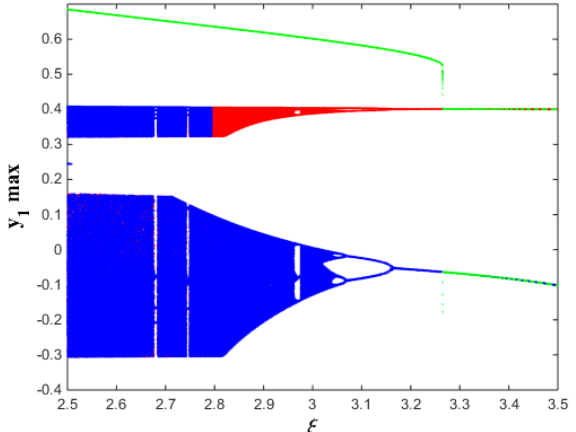
Figure 5. The bifurcation diagram of the integer − order MAVPD system with γ = 0.1, δ = 100, ρ = 200 and initial conditions [ 0.3651, 0.3519, 0.7303 ] T (green domain), [ 1 × 10 − 5 , 0, 1 × 10 − 5 ] T (red domain) and [ − 1 × 10 − 5 , 0, − 1 × 10 − 5 ] (blue domain).